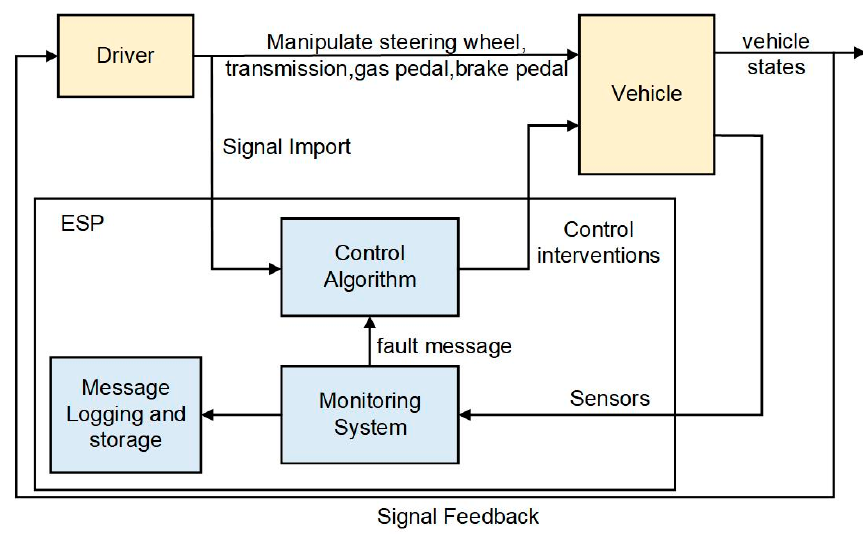
Figure 1. Components of vehicle dynamic stability control systems.